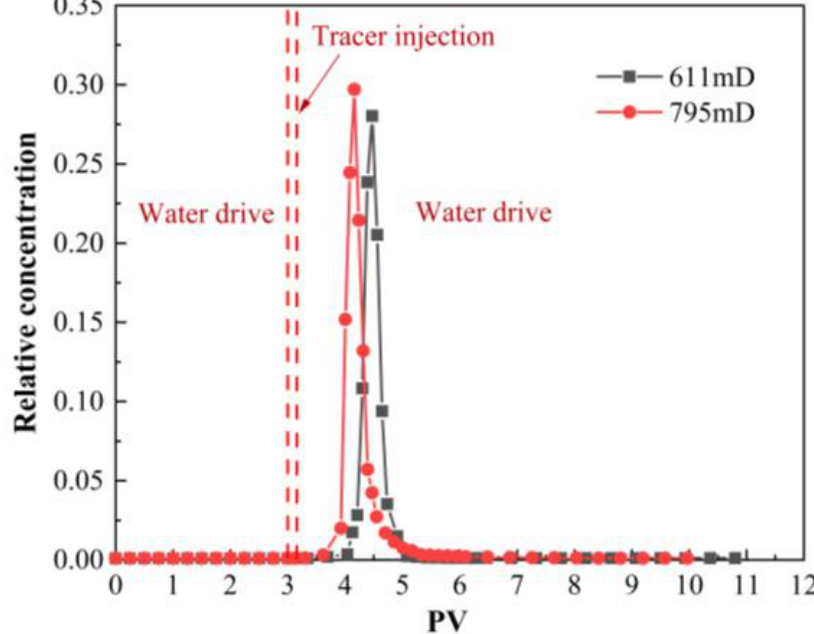
Figure 14. Relative concentration versus injection volume.